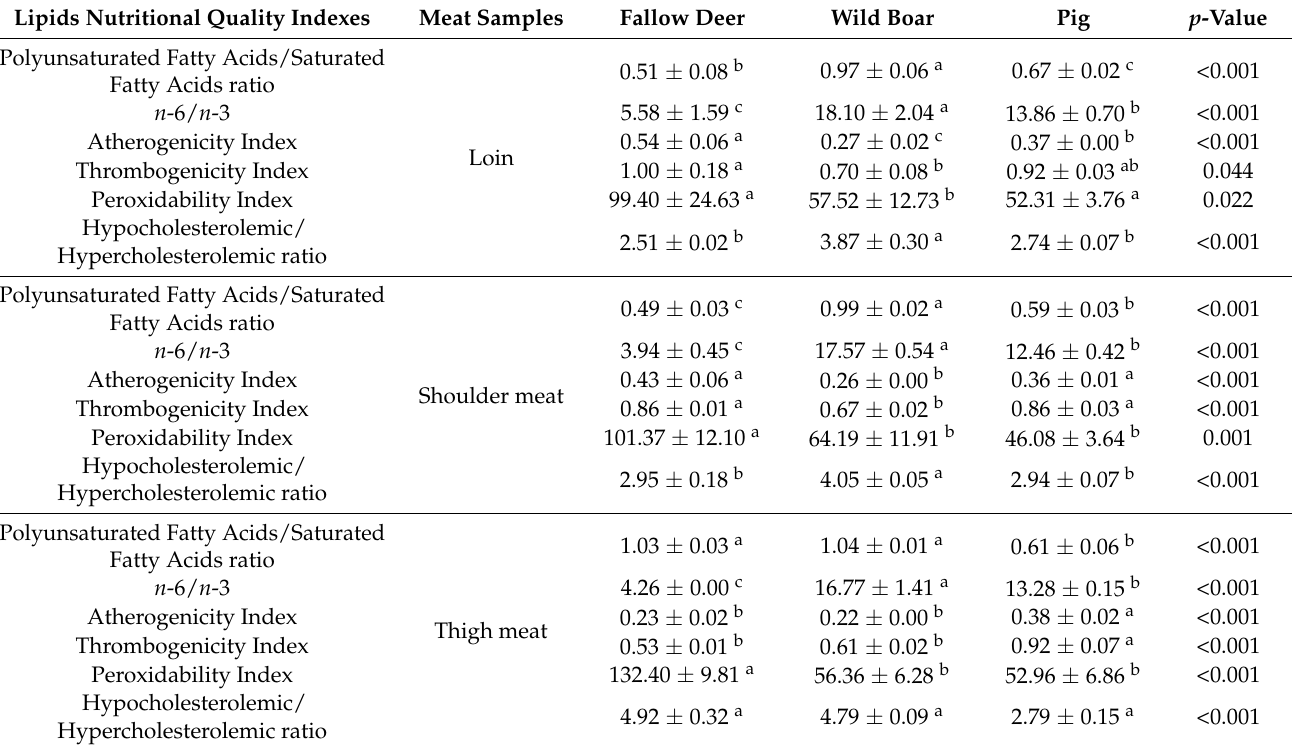
Table 5. The results of lipid nutritional quality indexes